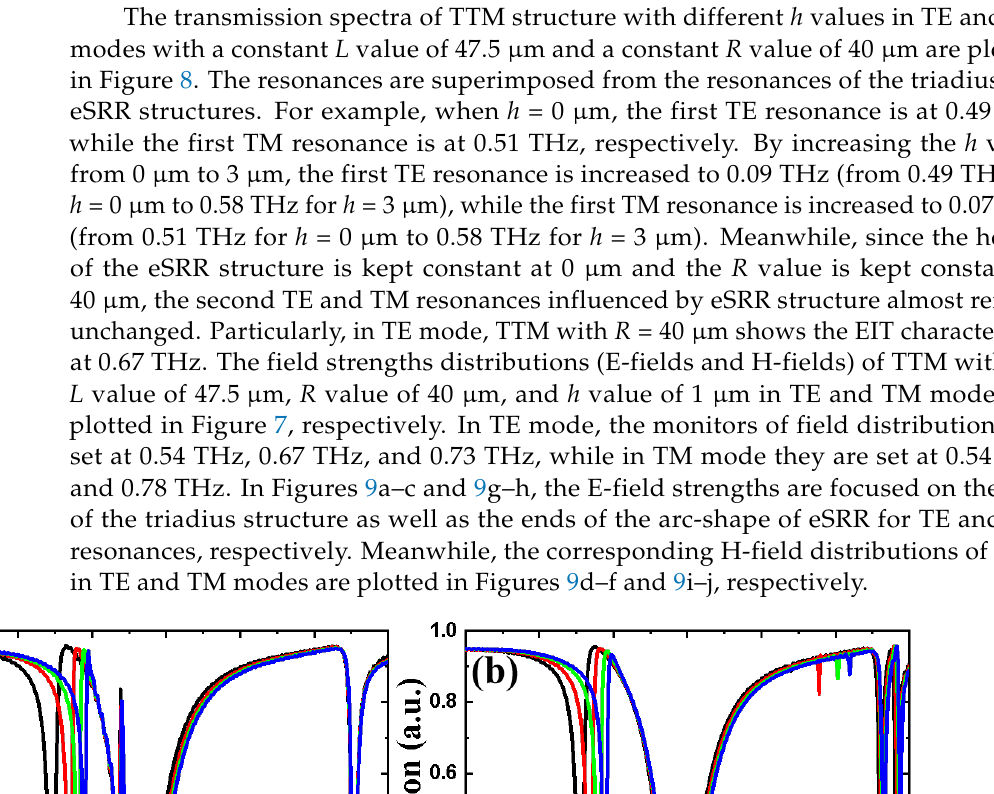
Figure 7. Field distributions of TTM with L = 47.5 μm and R = 40 μm in TE and TM modes. ( a – c , g , h ) are E-field distribu- tions. ( d – f , I , j ) are H-field distributions.